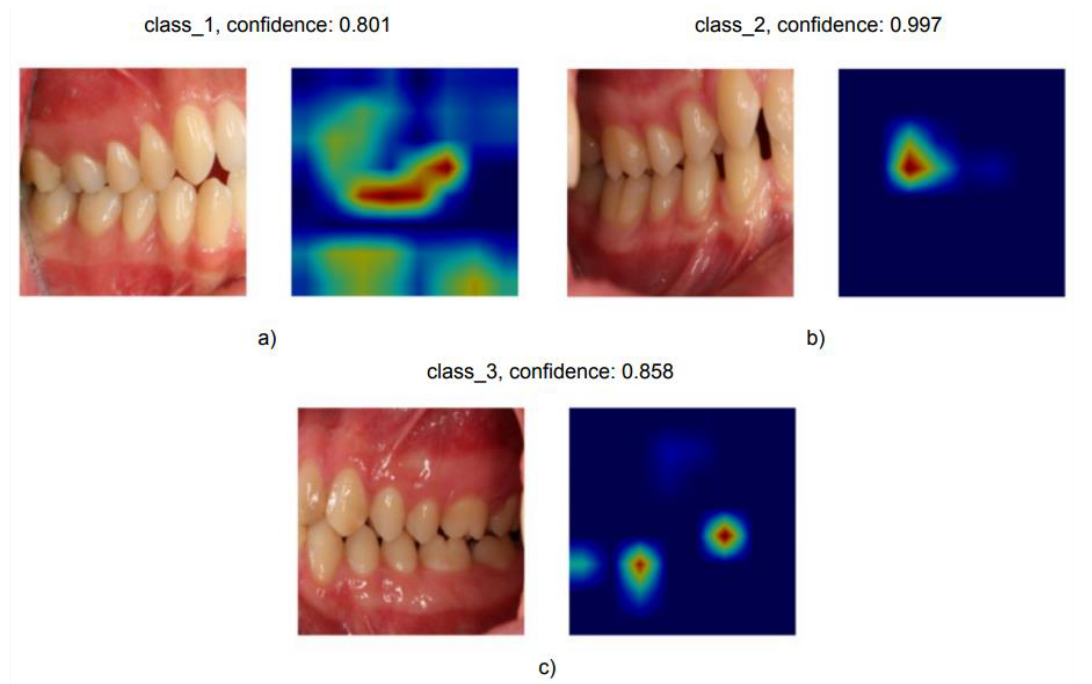
Figure 7. GradCAM visualization for some correctly classified images from Angle class I ( a ), class II ( b ) and class III ( c ). The red area indicates a high relevance for the particular outcome of the classification. Blue areas are not considered relevant for the Angle classification.